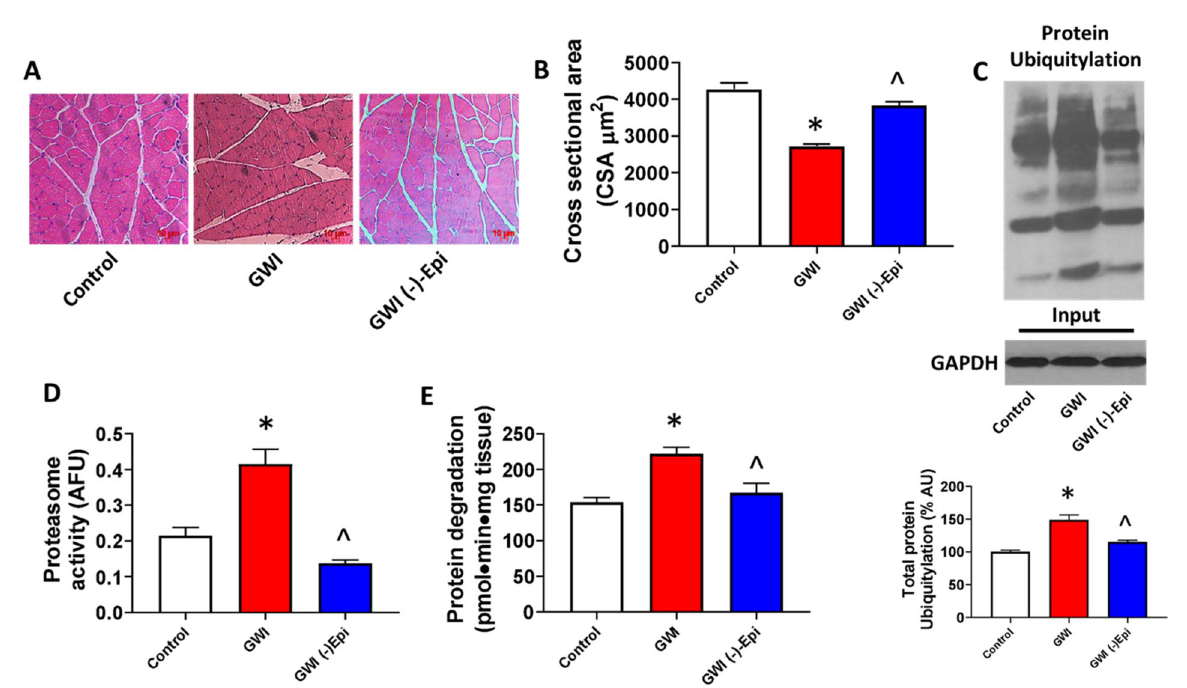
Figure 3. Effects of (−)-epicatechin (Epi) on GWI myofiber area, muscle protein ubiquitylation and degradation. (A,B) Images recorded from muscle stained with hematoxilin and eosin (scale bar = 50 µm) and reports on myofiber area measured by image analysis in control (n = 9), GWI (n = 5) and GWI-Epi (n = 5) rats. (C) An immunoblot image illustrating enhanced levels of muscle total protein ubiquitylation and reports on the relative quantification. (D) Reports on the quantification of proteasome activity (arbitrary fluorescent units = AFU) and (E) Reports on protein degradation by tyrosine release in gastrocnemius muscles *p < 0.05 vs. control, ^p < 0.05 vs. GWI by *p < 0.05 by